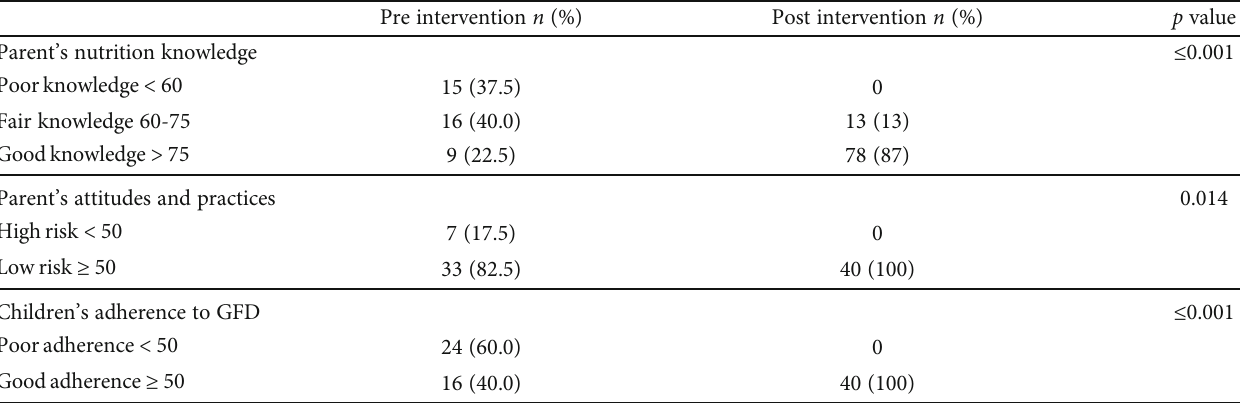
Table 6: Frequency of pre-/post intervention for the di ff erent categories of parent ’ s knowledge, attitudes, and practices and children ’ s adherence to GFD. Pre intervention n (%) Post intervention n (%)